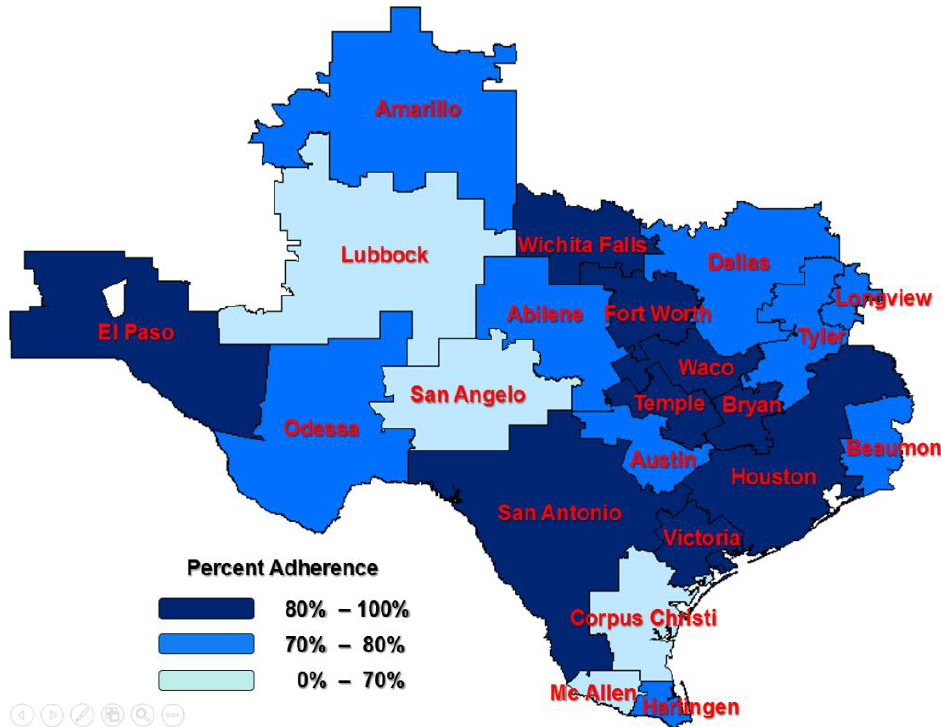
Figure 2. Adherence among Texas Hospital Referral Regions (HRRs) ; HRRs outside of Texas were not considered in the study.